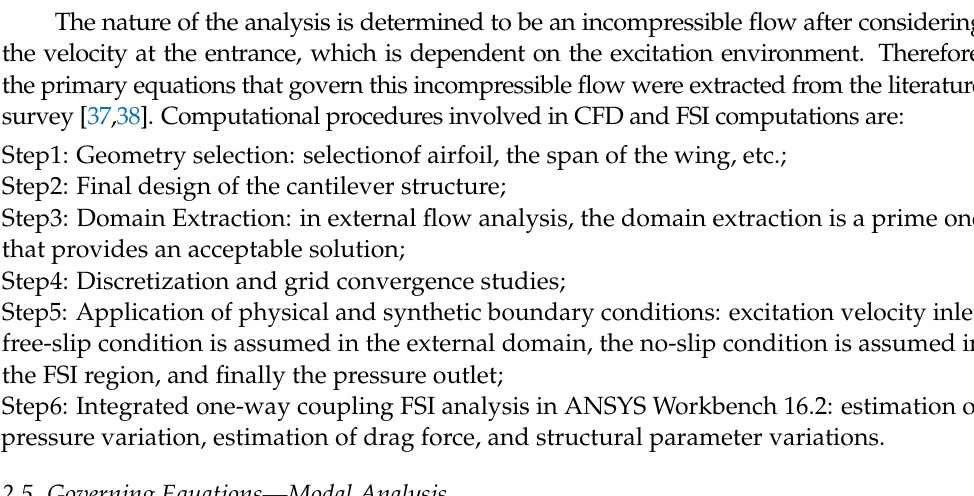
Figure 11. Structural boundary conditions of aircraft wing, finite element and modal analyses.